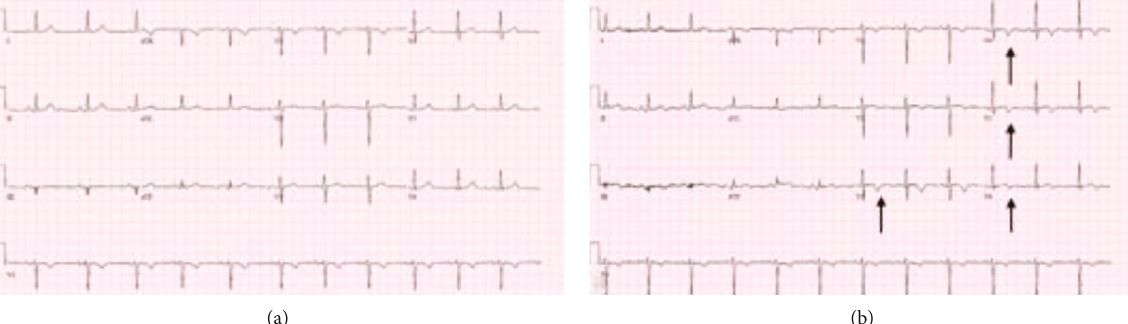
Figure 1: (a) EKG on admission and (b) EKG two hours later showing dynamic T wave changes in leads V3-V6 (demonstrated by the arrows).